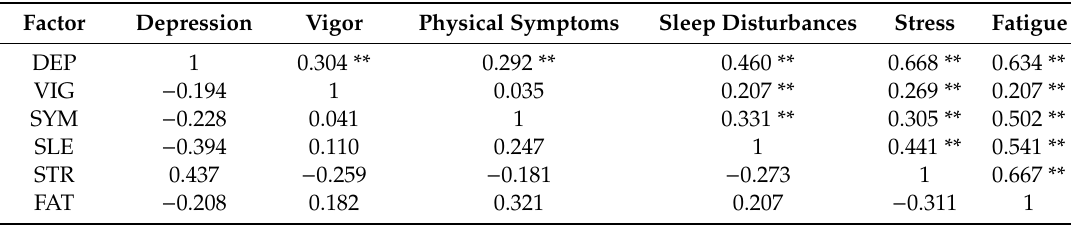
Table 7. Standardized inter-factor correlations from the alternative model above the diagonal and inter-correlations from the initial study of MTDS are presented below the